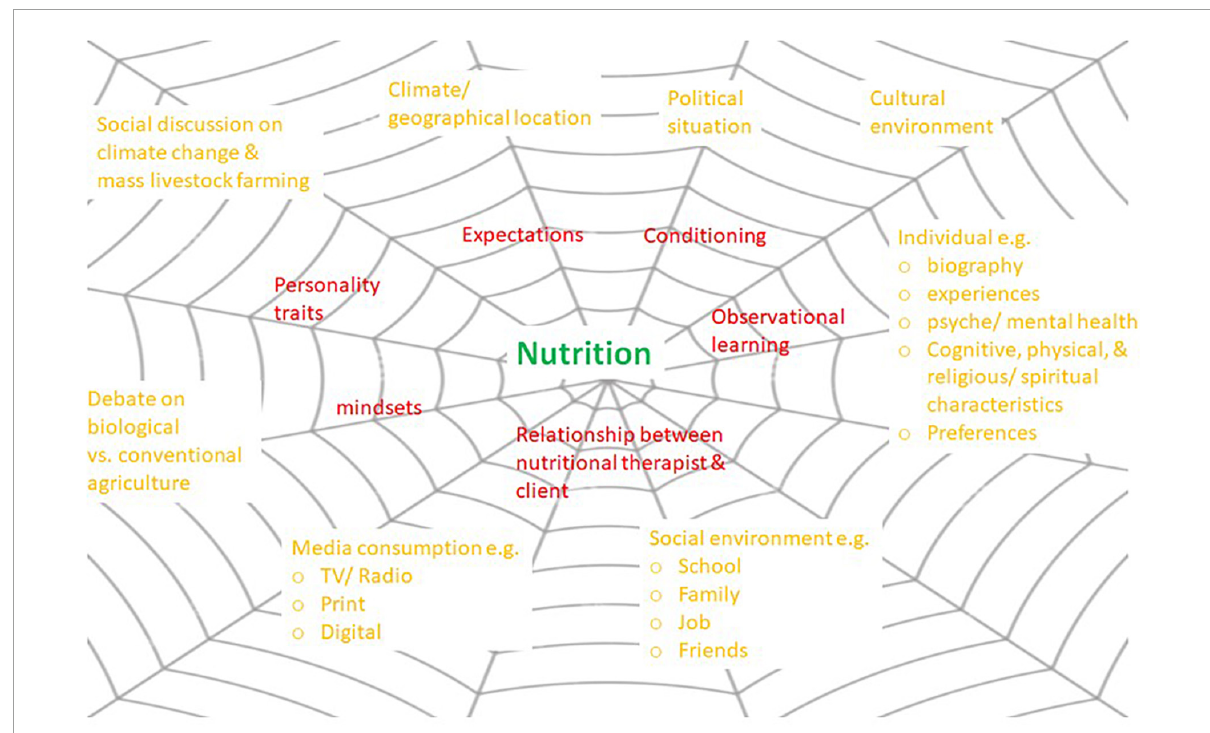
FIGURE1 PE and NE (micro context, red) and PSCE (macro context, orange) in nutrition which interact with each other and have the potential to influence the outcomes of diet changes (source: own